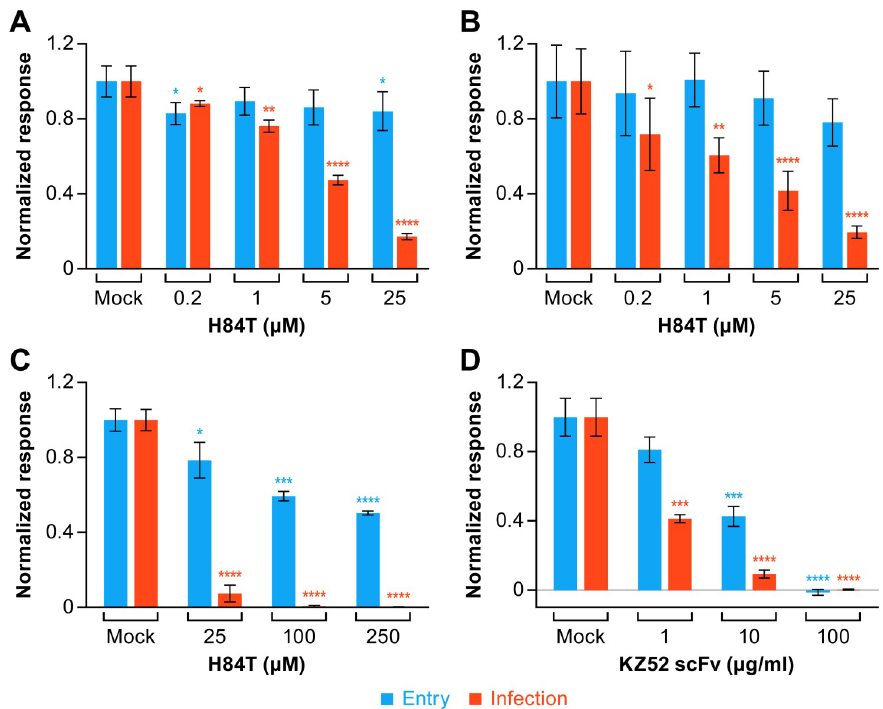
processed and analyzed for VLP entry and trVLP infection, with H84T present throughout, as described in the Methods section. VLP entry (blue bars) and trVLP infection (red bars) were scored at 3 and 48 h post addition of VLPs or trVLPs, respectively. (D) VLPs and trVLPs were pretreated with the indicated concentration of the anti-EBOV single chain antibody KZ52-scFv for 1 h at 37˚C. Cells were then processed and analyzed as in panels